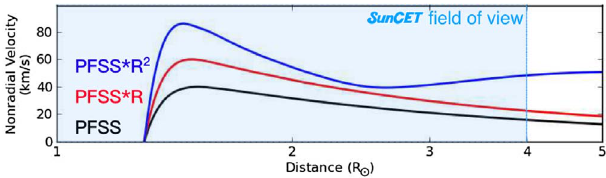
Fig. 5. ForeCAT simulations of a CME propagating through background magnetic fi elds (PFSS) of various strengths. R is radial distance. CMEs experience greater non-radial velocity in middle corona environments with stronger magnetic fi elds. The SunCET FOV (0 – 4 R (cid:1) ; indicated in light blue) captures the majority of CME de fl ection. Adapted from Kay